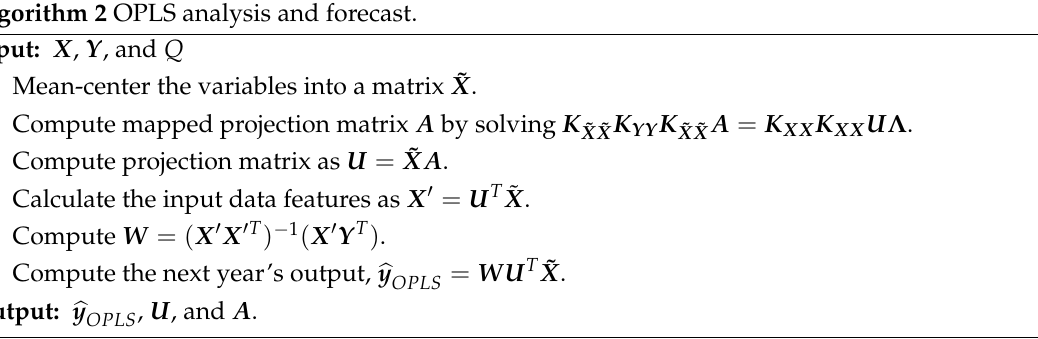
Algorithm 2 OPLS analysis and